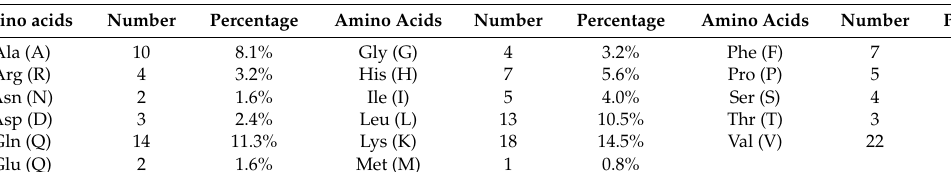
Table 2. Amino acid composition of Bx-cpi.